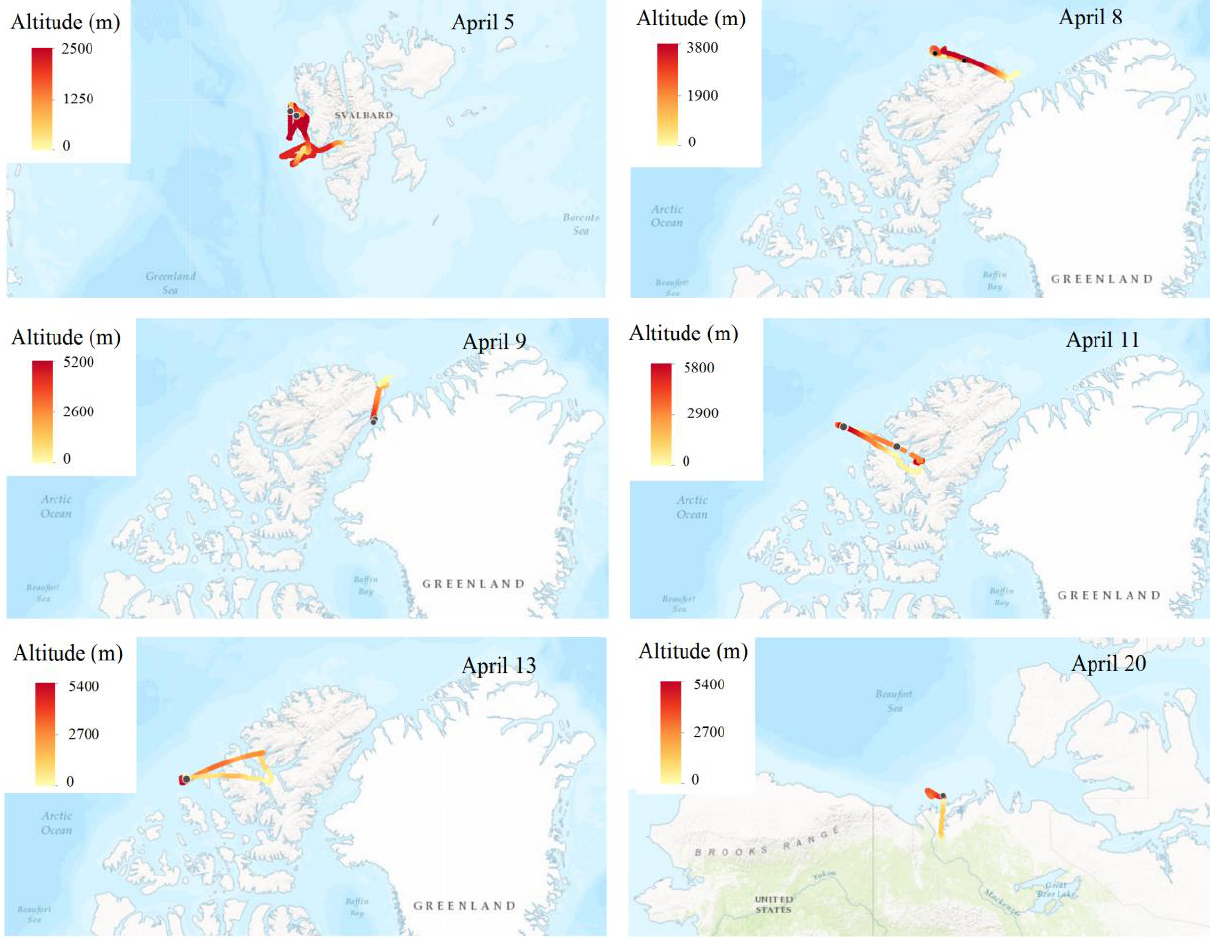
Figure 2. Polar 6 aircraft routes from 5 to 20 April 2015. Colour bars indicate altitudes, and sampling locations are shown with black dots.